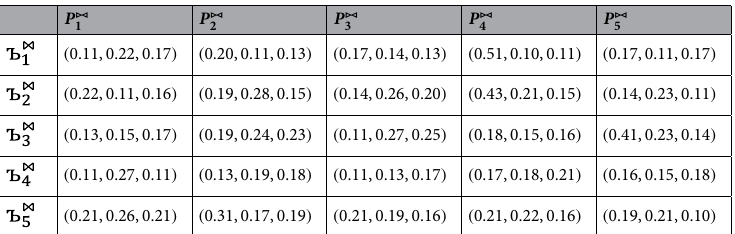
Table 5. Picture fuzzy soft data for F